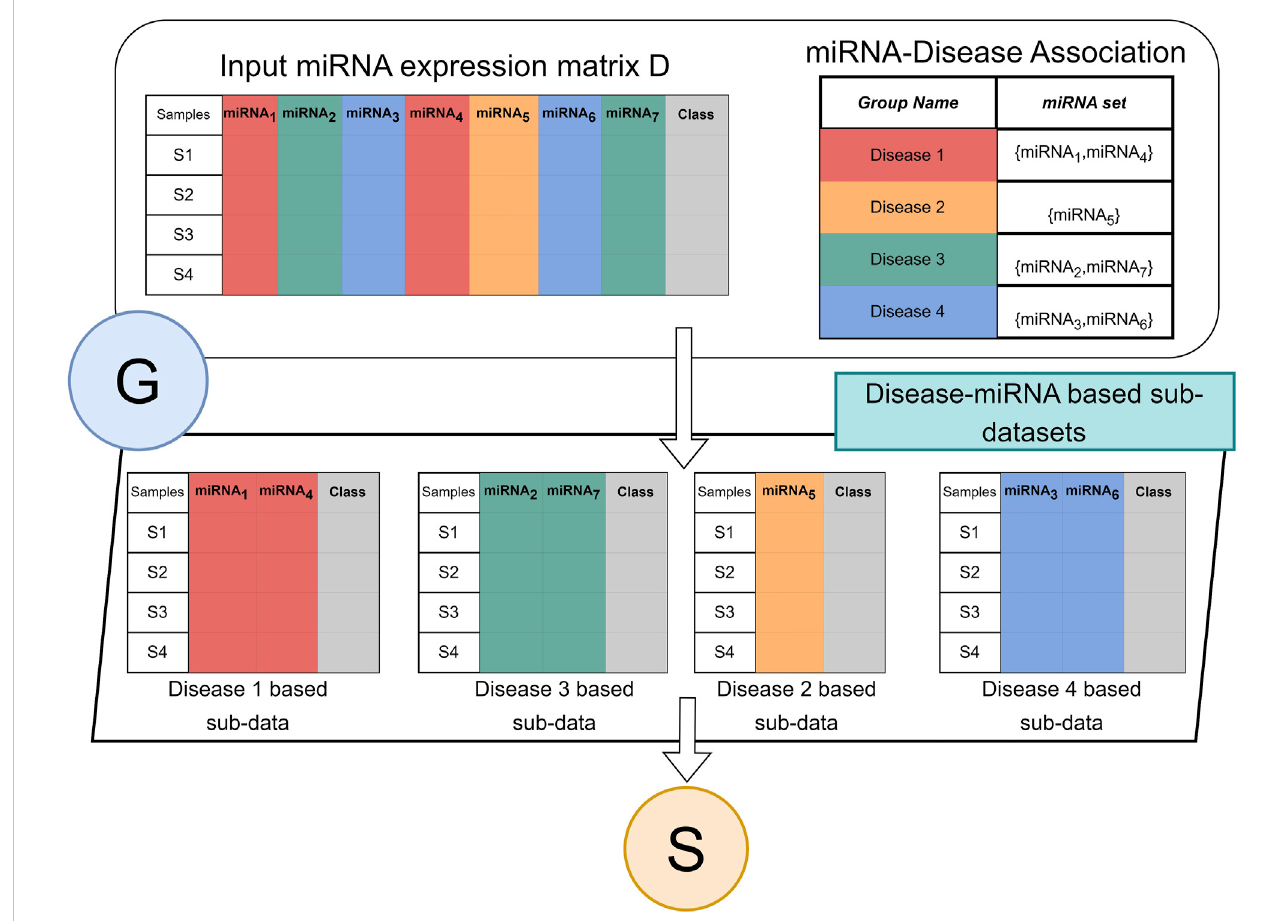
FIGURE 2 Architecture of G component for miRdisNET. An example showing how to construct disease sub-datasets based on miRNAs associated with a